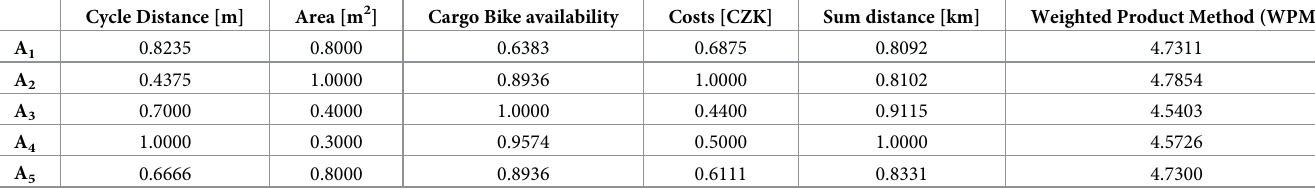
Table 18. Normalization of the input data.